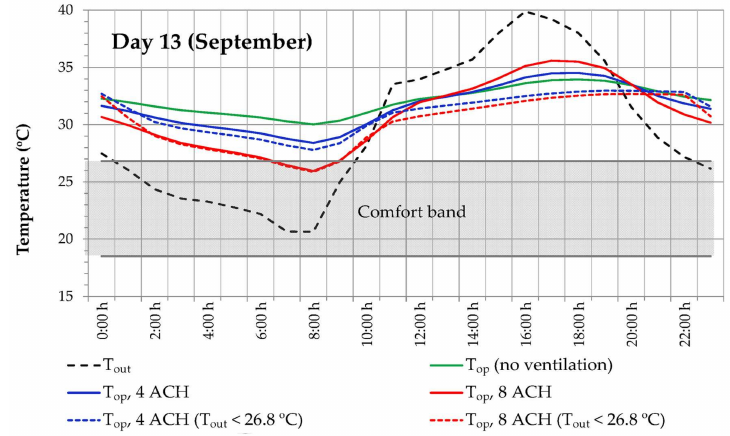
Figure 16. Influence of ventilation on thermal evolution during the hottest day in September, considering free-running protocols studied (night-time ventilation: 22:00 to